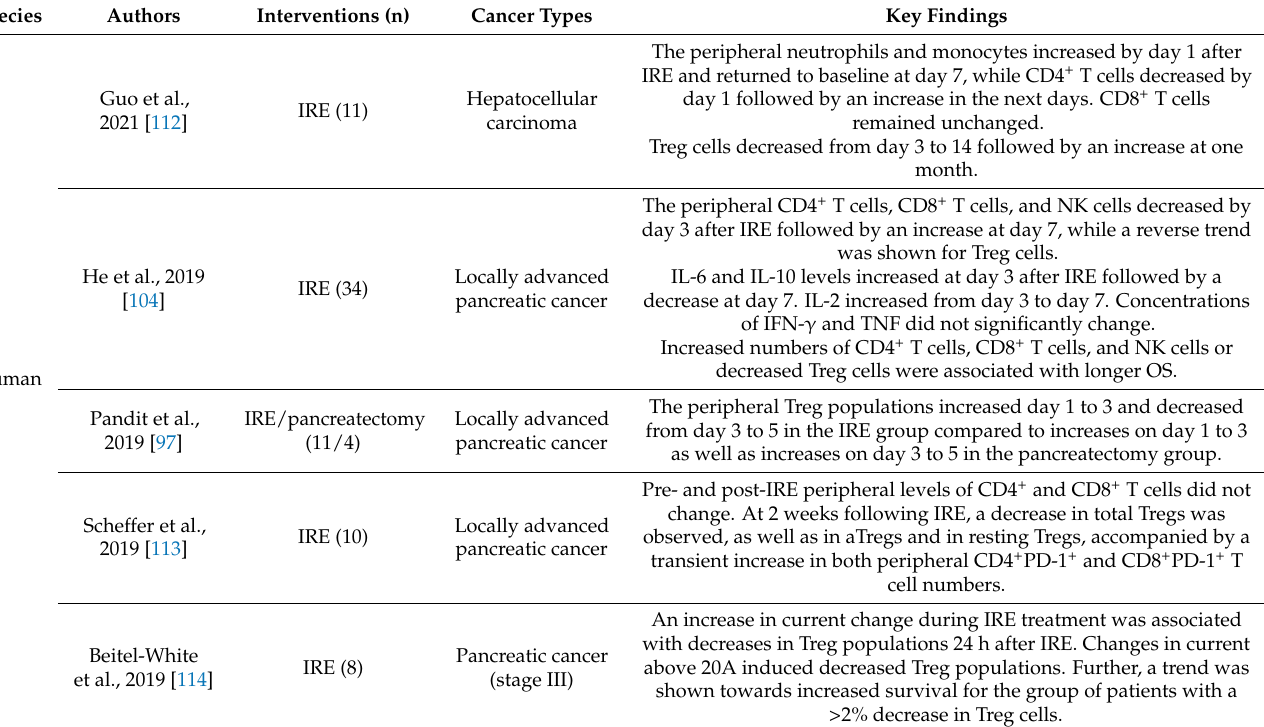
Table 2. Summary of IRE studies investigating the effects on the immune